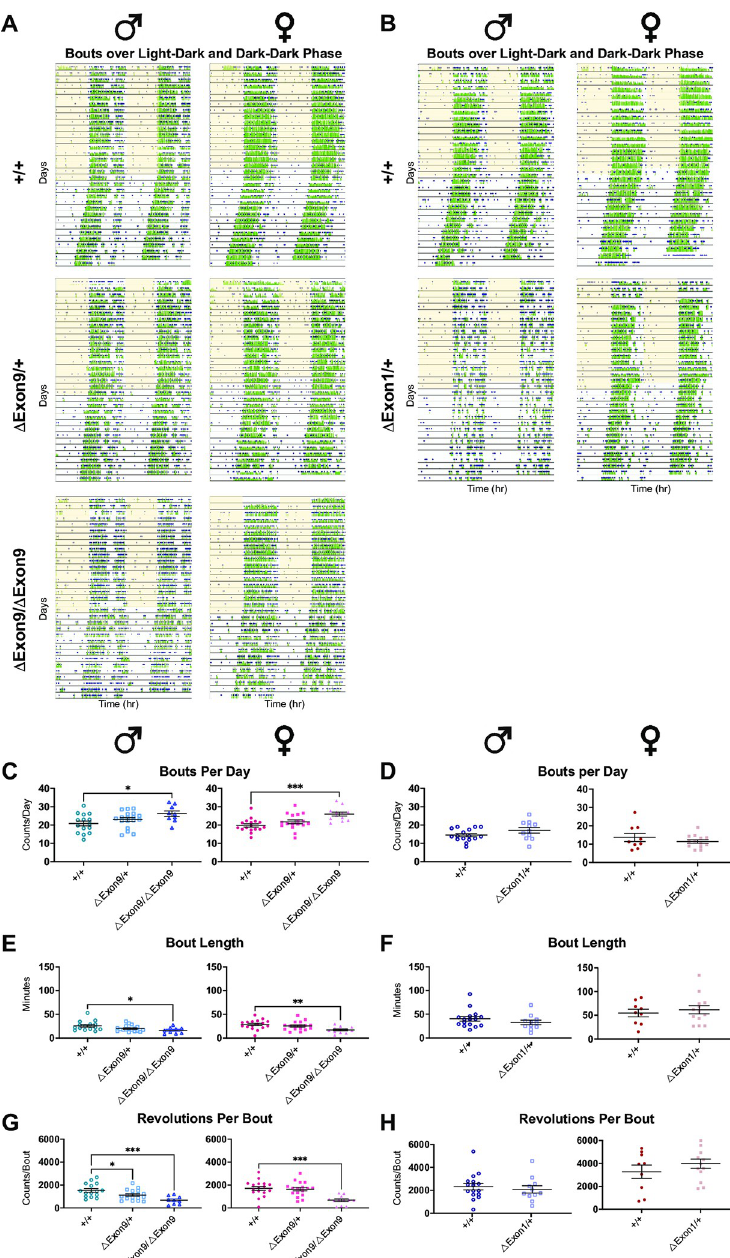
Fig 5. A reduction in Nrxn1 α expression alters circadian bout activity. A-B. Representative actograms with activity indicated in green and bouts marked with blue squares from mice under two different lighting conditions: (1) 12 h of light (indicated by the yellow shading) followed by 12 h of dark (L/D) and (2) constant dark (D/D). Actograms depict locomotor activity (wheel revolutions) in green across time with days stacked vertically and double plotted with the x axis spanning 2 days (48 hours). C-D. Bouts per day in the L/D phase across sex and genotype. (C) Ordinary one-way ANOVA with Holm-Sidak’s multiple comparison test; � p < 0.05 and ��� p < 0.001. (D) If groups were normally distributed (D’Agostino & Pearson test) and didn’t have significantly different variance (F test), the unpaired t test was used. If samples were not equally distributed or had different variances, Welch’s t test was used. E-F. Bout length in the L/D phase across sex and genotype. (E) Kruskal-Wallis test with Dunn’s multiple comparison test; � p < 0.05; one-way ANOVA with Holm-Sidak’s multiple comparison test, �� p < 0.01. (F) If groups were normally distributed (D’Agostino & Pearson test) and didn’t have significantly different variance (F test), the unpaired t test was used. If samples were not equally distributed or had different variances, Welch’s t test was used. G-H. Revolutions per bout in the L/D phase across sex and genotype. (G) One-way ANOVA with Holm-Sidak’s multiple comparison test, � p < 0.05